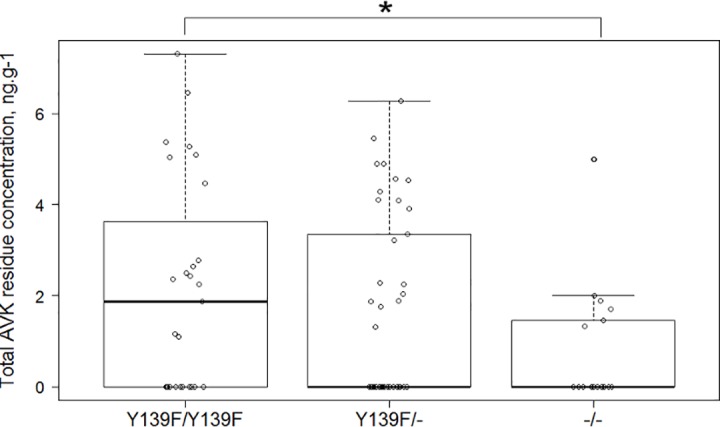
Boxplot and scatterplot of the total AVK residue liver concentration (ng.g-1) depending on the VKORC1 genotype (log scale).